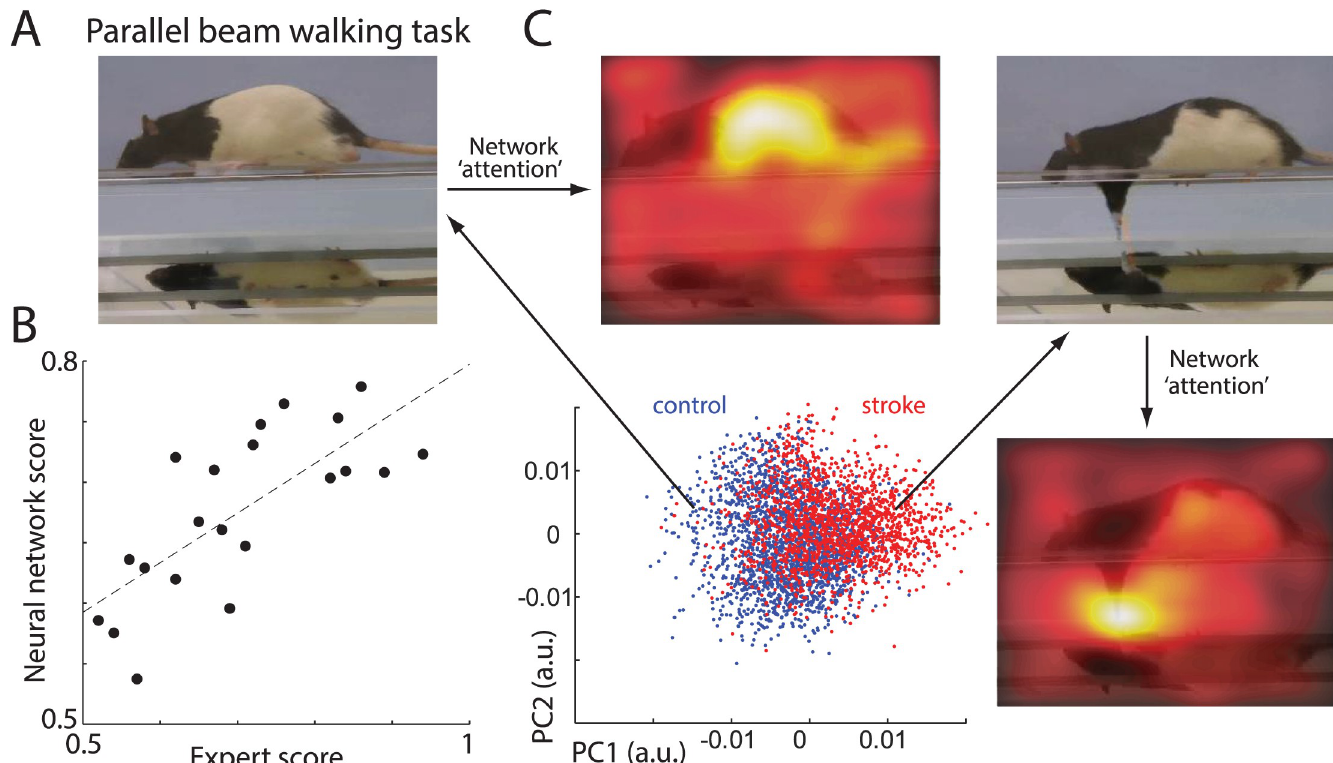
Fig 10. Network validation on different behavioral tasks. (A) Sample frame showing a rat on the parallel-beam-walking task. Note the mirror below the rat is showing an additional view of paw placement. (B) Relationship between expert and network scoring. Each dot represents the average score for a single rat. (C) Representation of video frames transformed into the internal feature space of the network. Each point represents a single video fame. Blue points represent video frames from control rats and red points from stroke rats. For picture clarity, only 20% of randomly selected points are shown. Long arrows point to sample video frames from control and stroke groups. Short arrows point to “attention” maps superimposed on frames: parts of frames most informative for network decision (marked in lighter colors). It indicates that similar to experts, the network uses foot slips to score stroke deficits (micro symptoms), but it also discovered that body posture and/or speed (macro symptoms) improves scoring. The sample network on which this figure is based is available at github.com/hardeepsryait/behaviour_net. a. u., arbitrary units; PC, principal component.